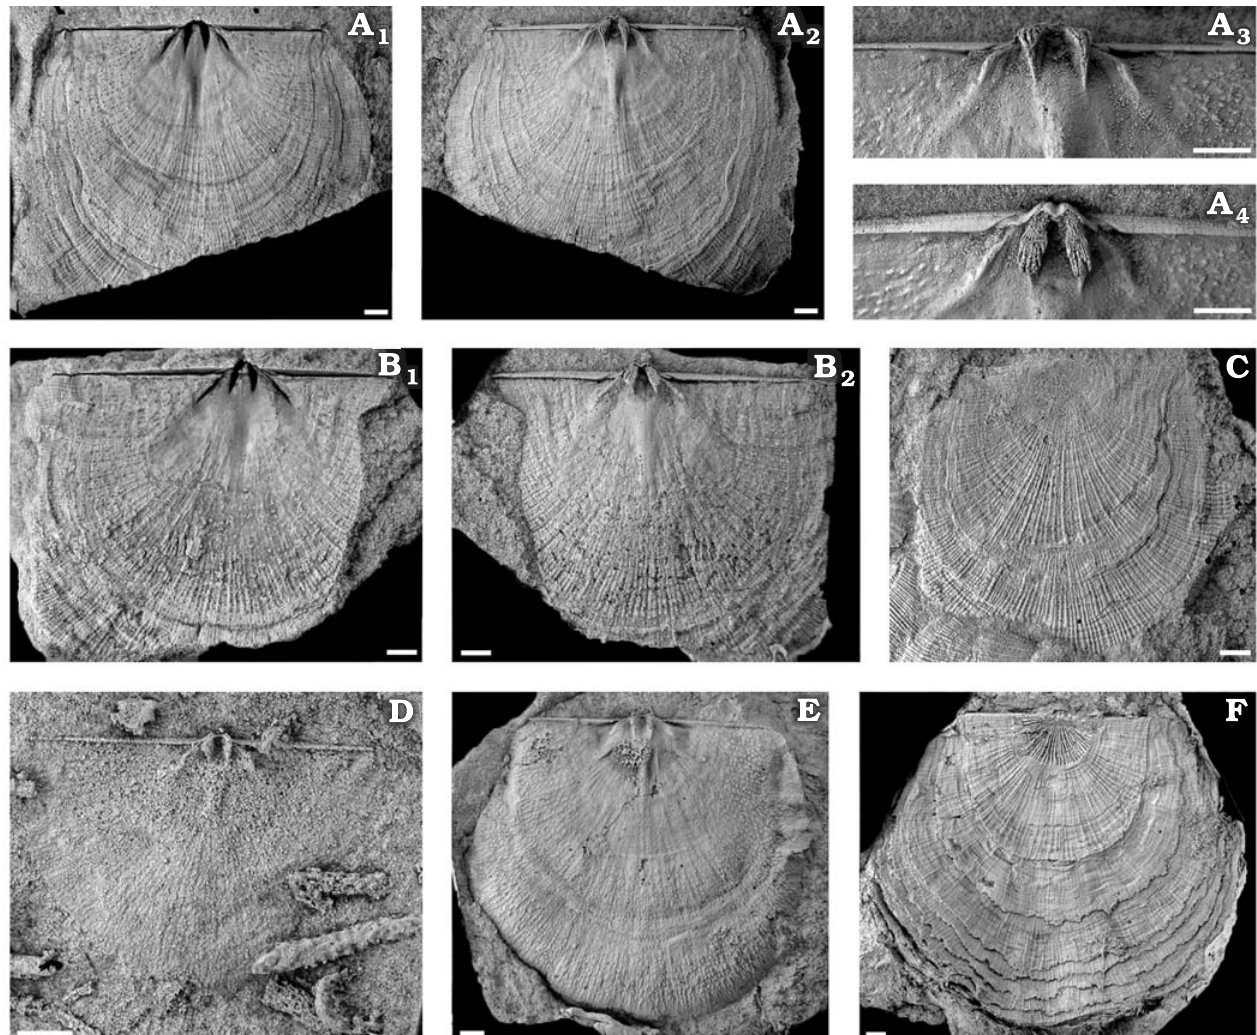
Fig. 18. Dorsal valves of rafinesquinine brachiopod Rafinesquina ( Mesogeina ) pseudoloricata (Barrande, 1848); lower–middle Katian (Ka1–2), Upper Ordovician; Zahorany Formation, Bohemia, Czech Republic (A–C); Peña del Tormo Member of the Fombuena Formation, Iberian Chains, Spain (D); Porto de Santa Anna Formation, Portuguese Central Iberian Zone, Portugal (E, F). A . MPZ 2015/1394, dorsal internal mould (A 1 ) and latex cast of dorsal interior (A 2 ), detail of cardinalia in anteroventral (A 3 ) and posteroventral (A 4 ) views. B . MPZ 2015/1395, internal mould (B 1 ) and latex cast of interior (B 2 ). C . MPZ 2015/1396, latex cast of dorsal exterior. D . MPZ 2015/1397, latex cast of interior of a small valve. E . IGM-2934, latex cast of interior. F . IGM-2936, latex cast of dorsal exterior. Scale bars 2